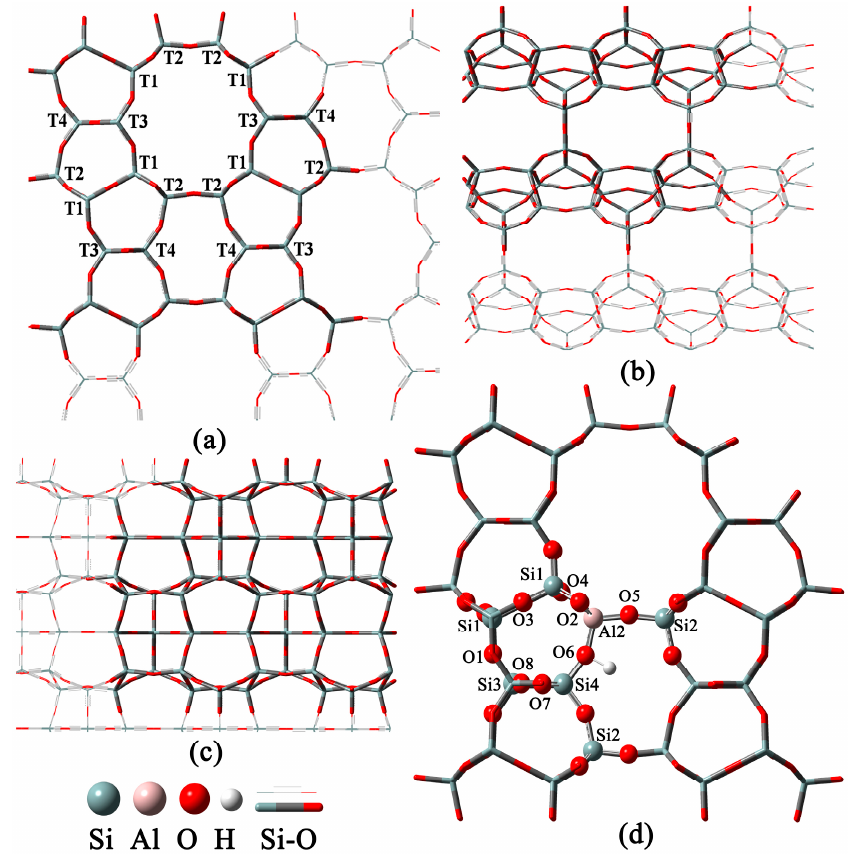
Figure 7. The structure of FER zeolite. ( a ) is the projection along [001], ( b ) [010], and ( c ) [100]. 90T is cut out from cluster ( a ) as the model in this study. Locations of all T sites are shown in ( a ). T1, T2s and T3 are located on the 10 ‐ membered ring; T1, T2, and T4 are on the surface of the FER cage. 1 ‐ Al substitution models are shown in ( d ). When the T2 site was studied, the region (10T), depicted by balls around the center T2 site, was treated at high ‐ level and the rest was treated at low ‐ level. All calculations were carried out by the Gaussian 09 package (Revision C.01; Gaussian, Inc.: